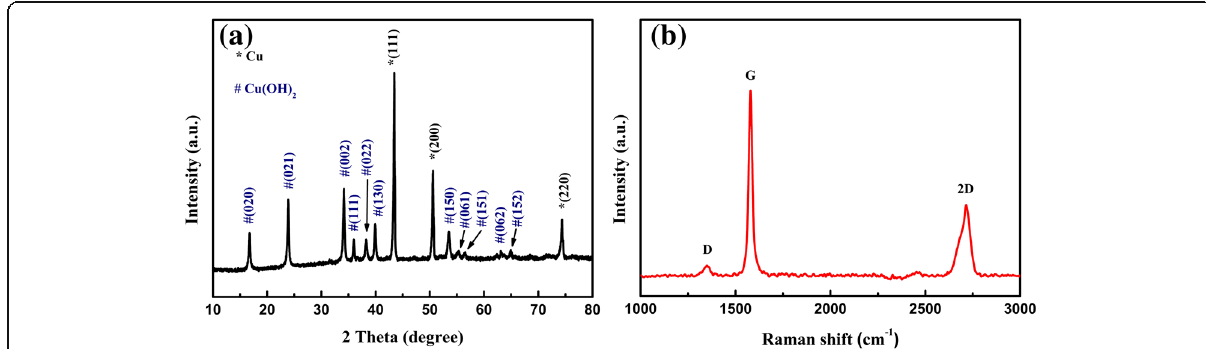
Fig. 2 a X-ray diffractogram and b Raman spectra of Cu(OH) 2 /graphene